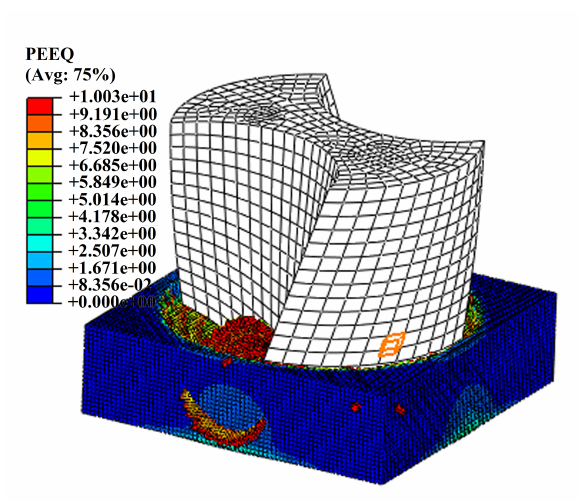
Fig. 3. Equivalent plastic strain